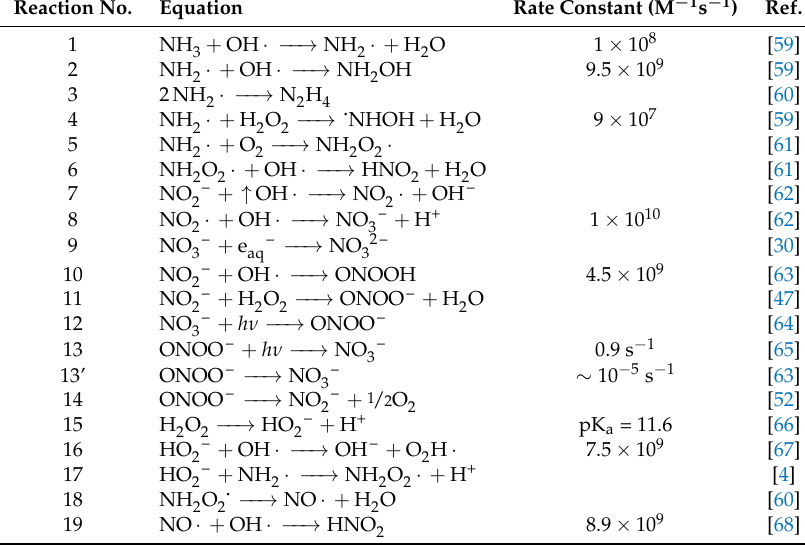
Table 1. Proposed reactions, rate constants, and references for photolysis of water and ammonia. Reaction No.